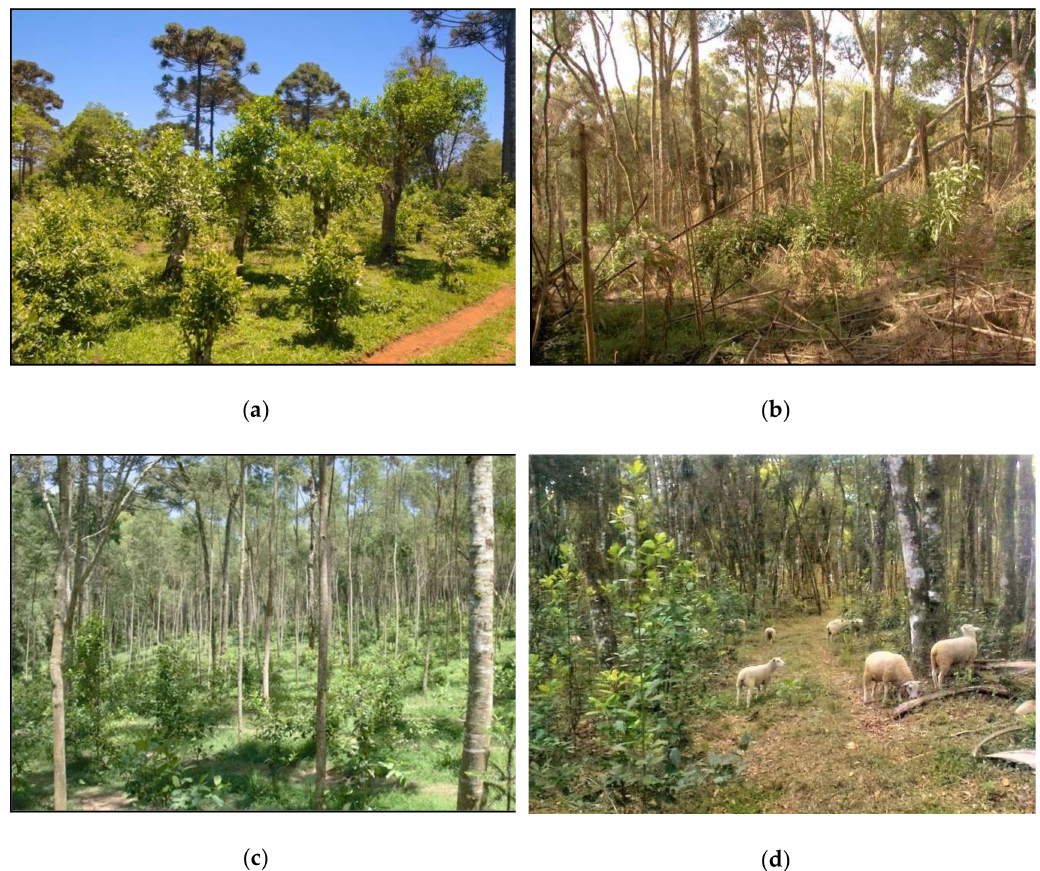
Figure 2. Traditional agroforestry optimization: ( a ) traditional erva-mate production where the lack of adequate forest management caused canopy decline leading to monoculture-like erva-mate production; ( b ) understory management, with initial removal of invasive native bamboos, for production and species diversification; ( c ) induced forest regeneration for canopy restoration (white trunks), followed by erva-mate plantation (increased production) and diversified tree plantation (species and forest structure diversification); ( d ) sheep used for weed control in a newly implemented erva-mate intensification